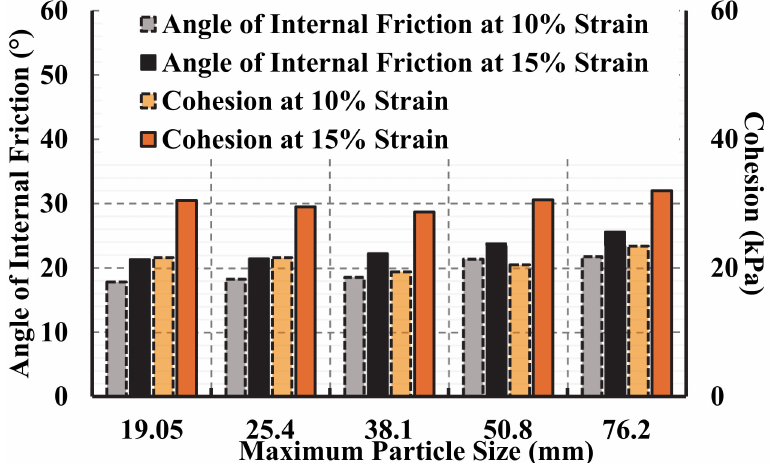
Figure 8. Angle of internal friction and cohesion for the five